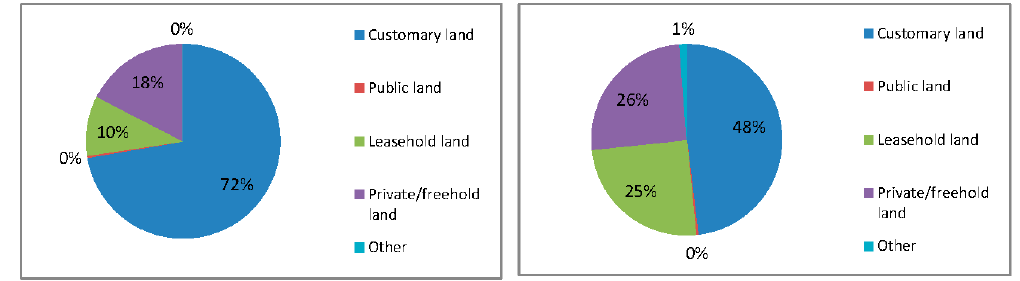
Figure 11. Tenure of the land when acquired ( left ) and after acquisition ( right ) (in percentages of number of cases) ( N = 300). Source: Authors’ medium-scale farm survey in the Mchinji, Kasungu and Lilongwe Districts undertaken by LUANAR, UP, and MSU (2014–2015).